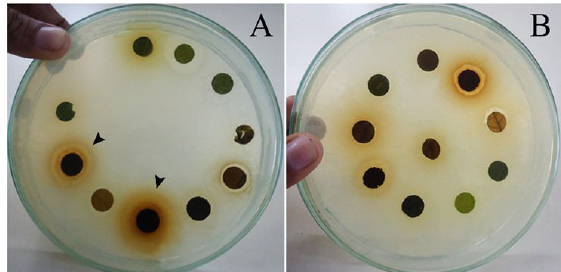
Figure 1: Petri plates (A) and (B) demonstrate screening of various plant species for their antibacterial activity by leaf disc antimicrobial assay. The diffusion of phytochemicals can be seen in the form of color change around the discs (pale yellow or pale brown). The zone of inhibition varied from disc to disc and can be seen around few discs indicating